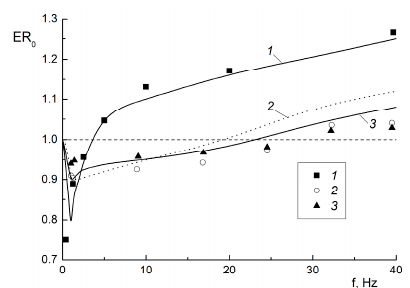
Figure 10. The effect of pulses frequencies on heat transfer enhancement ratios for rectangular ( 1 ), sinusoidal ( 2 ) and triangular ( 3 ) types of signal. Points are the measurements results of [15] and lines are authors’ predictions. Re = 7500, D = 15 mm, H / D = 6, q W = 420 W / m 2 , St = (0.2–8) × 10 − 2 .